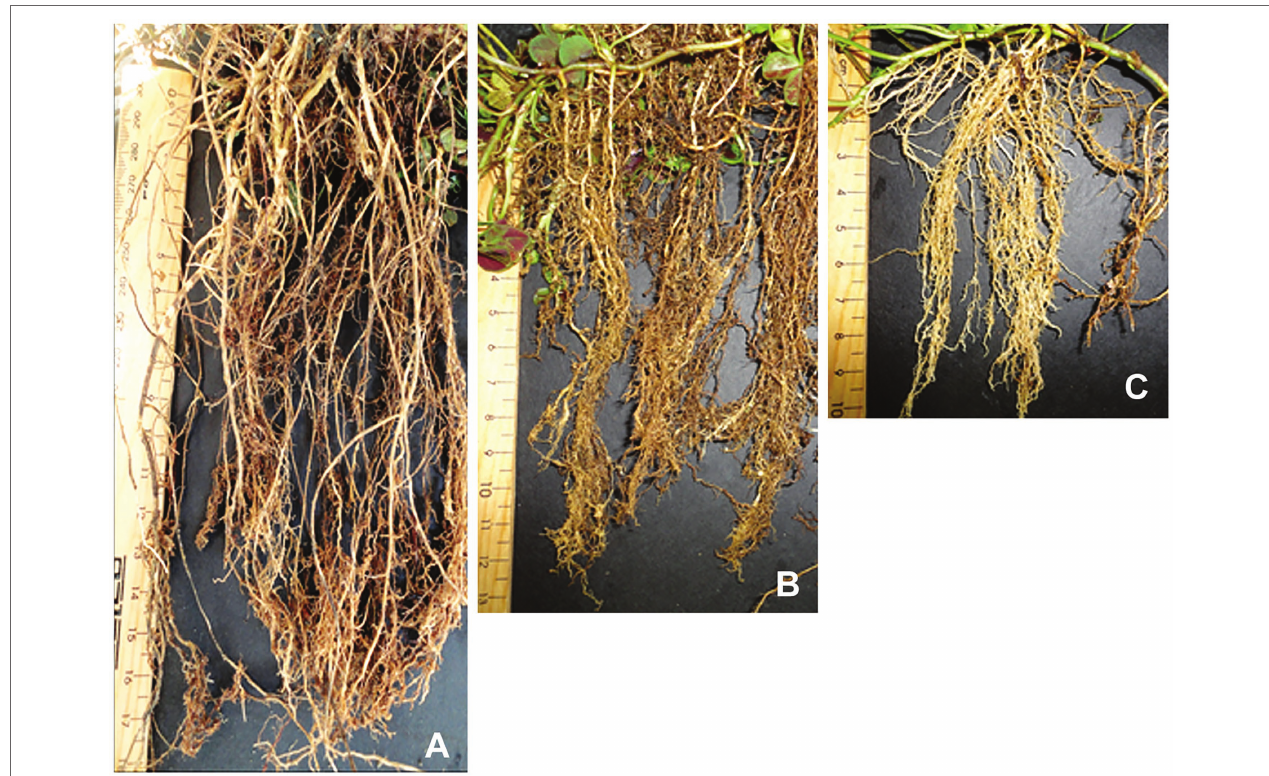
FIGURE 4 | Root morphology of BC 2 -126 (A) as compared with control white clover genotypes colored white clover, PxB (B) and Kopu II (C) . The root system in BC 2 -126 was thicker and deeper compared to the white clover